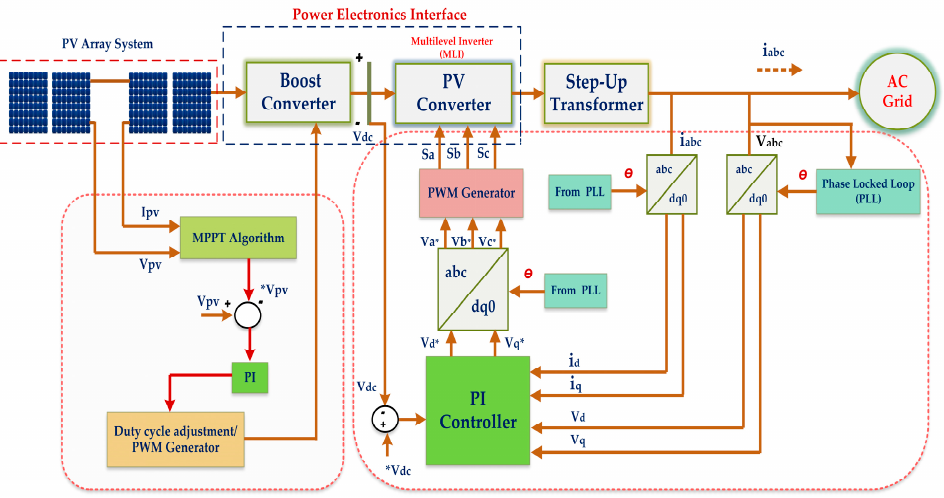
Figure 28. System con fi guration and control structure of a two-stage single-phase grid-connected PV system.